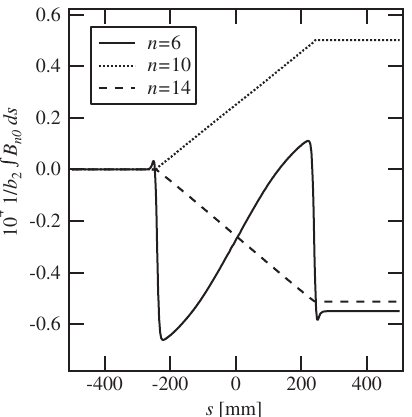
R ν normalized by s − ∞ B n 0 d